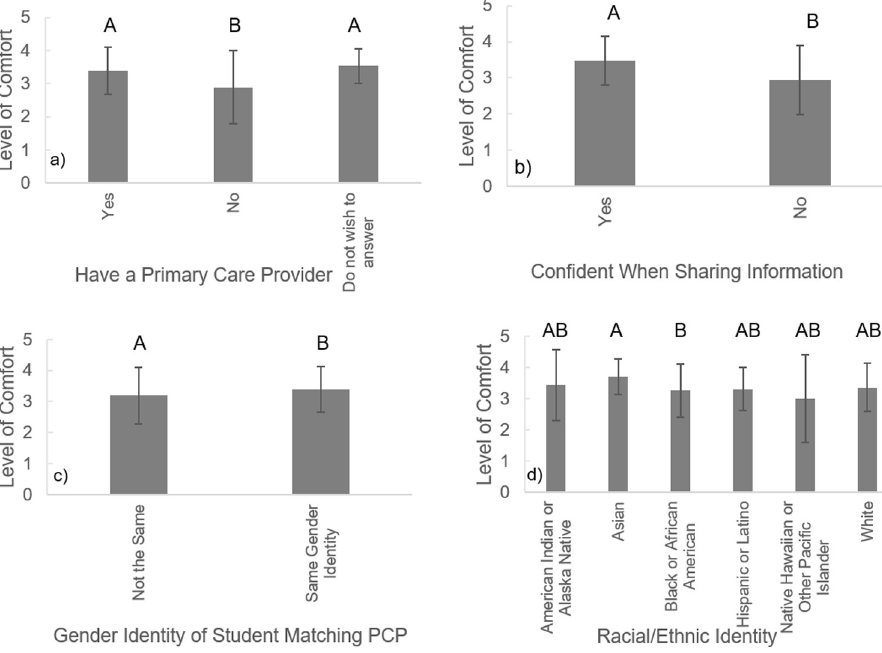
Fig 2. Relationship between the level of comfort (higher values mean a patient is more comfortable) students experience when visiting their medical provider based on a) if they have a primary care provider (PCP), b) if a student feels confident sharing online information they find with their medical provider, c) if the gender of the student and the medical provider match, and d) the racial/ethnic identity of the student. Error bars represent standard deviations. Bars that have the same letter(s) above them within a panel do not significantly differ from each